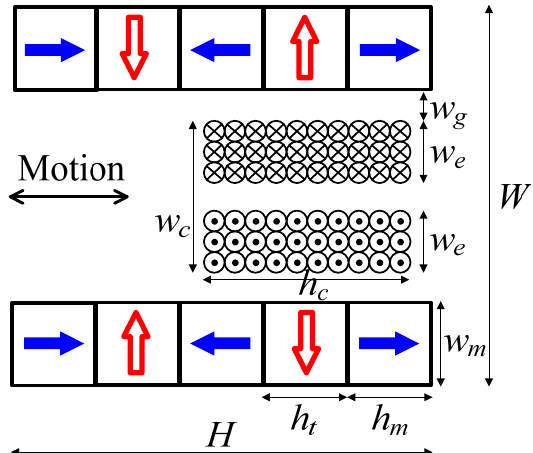
Figure 4. Optimization parameters for linear Halbach arrays and pick-up coils ( :main magnet and pole direction, : transit magnet and pole direction).